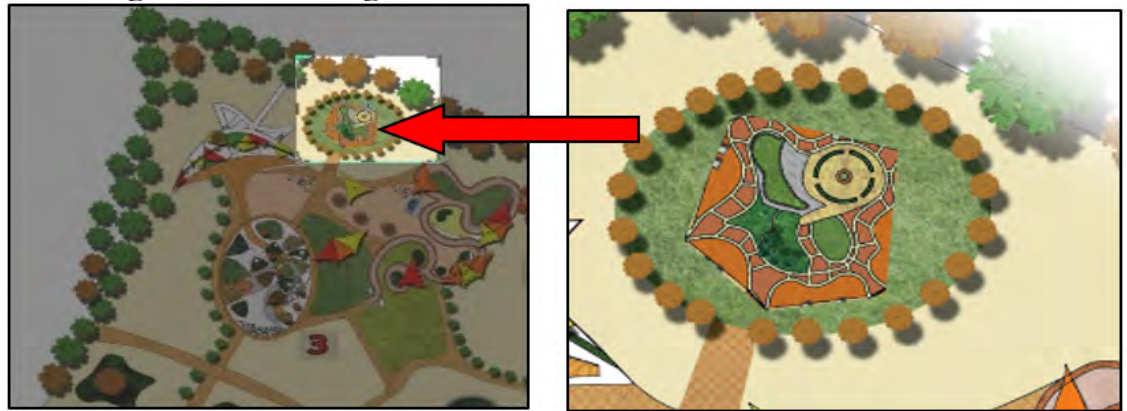
Figure 14. The location of fine and gross motor skills zone